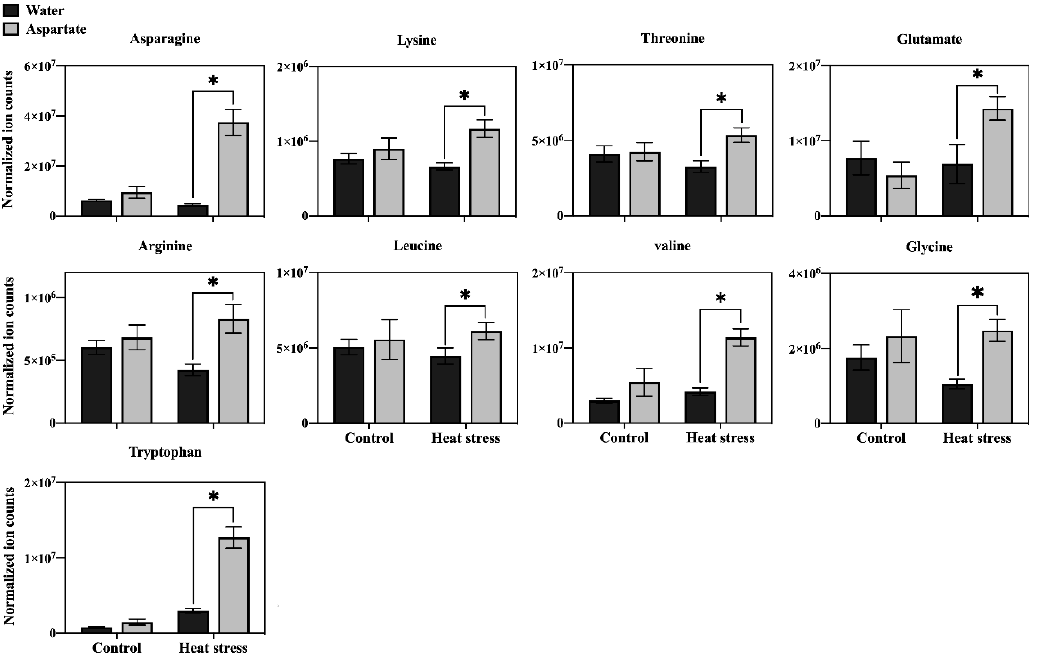
Figure 6. Effects of exogenous application of aspartate (Asp, 2 mM) on the content of amino acids in leaves of perennial ryegrass under control temperature and heat stress (30 d of treatment). Vertical bars over the column represent standard errors of a given data point, and * represents significant differences between water and Asp under control temperature and heat stress based on the LSD test at p = 0.05.